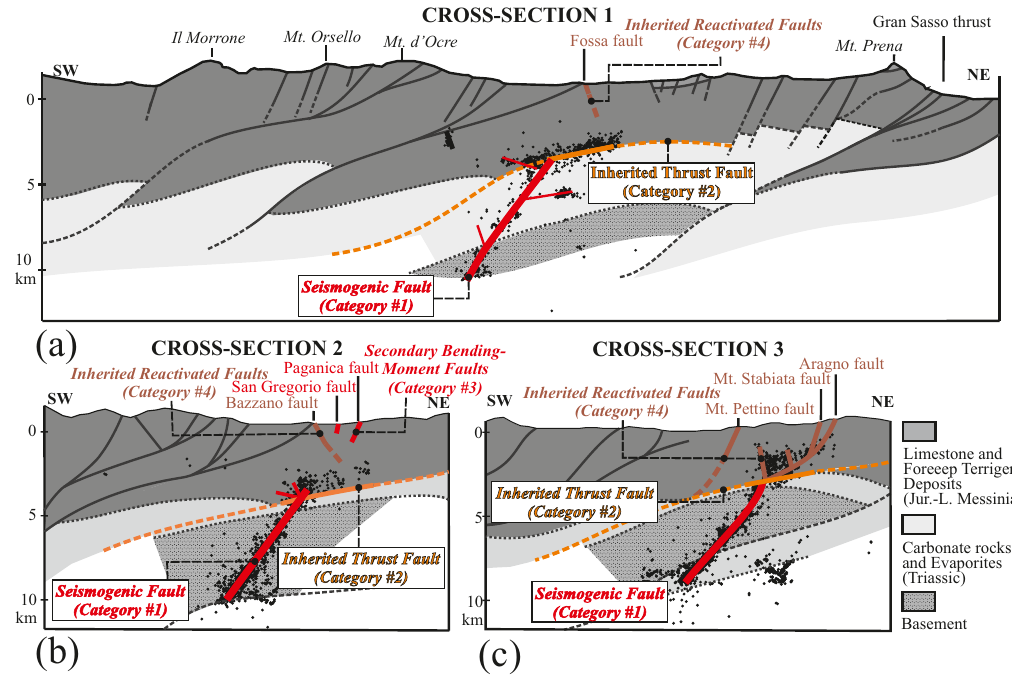
Figure 11. Geological cross sections showing different fault categories recognized in the L’Aquila area. Section traces are shown in Fig. 1.